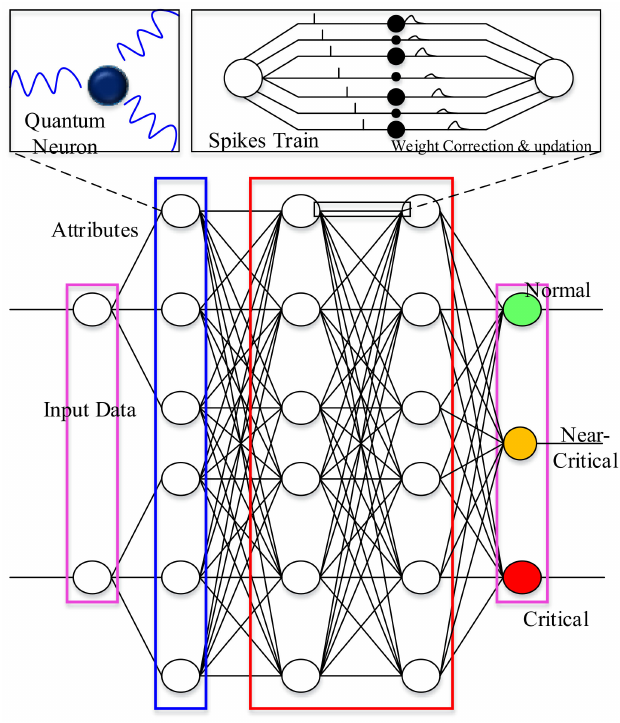
Figure 4. SpikQ-Network for Health Status